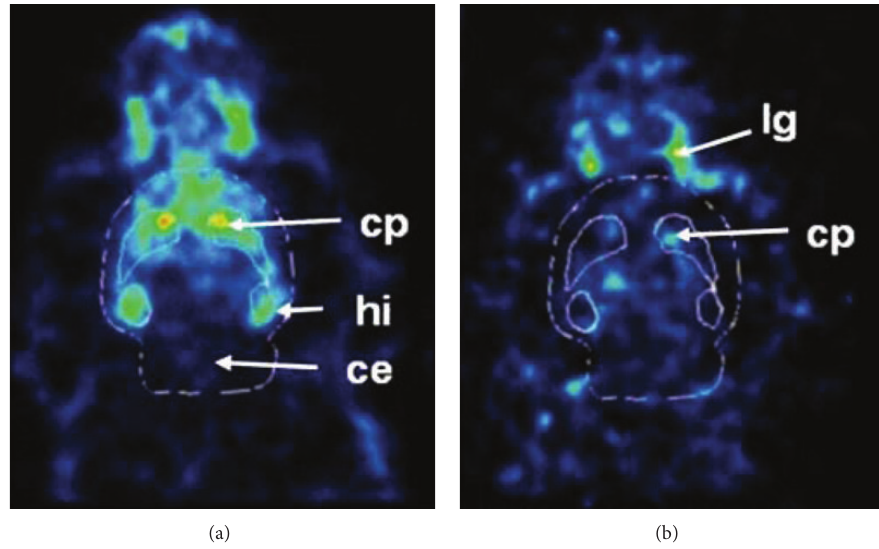
Figure 12: PET images of [ 11 C]ABP688 (0–30min) in control rats (a) and an mGluR5-selective ligand M-MPEP (1.0mg/kg) treated rat [94].